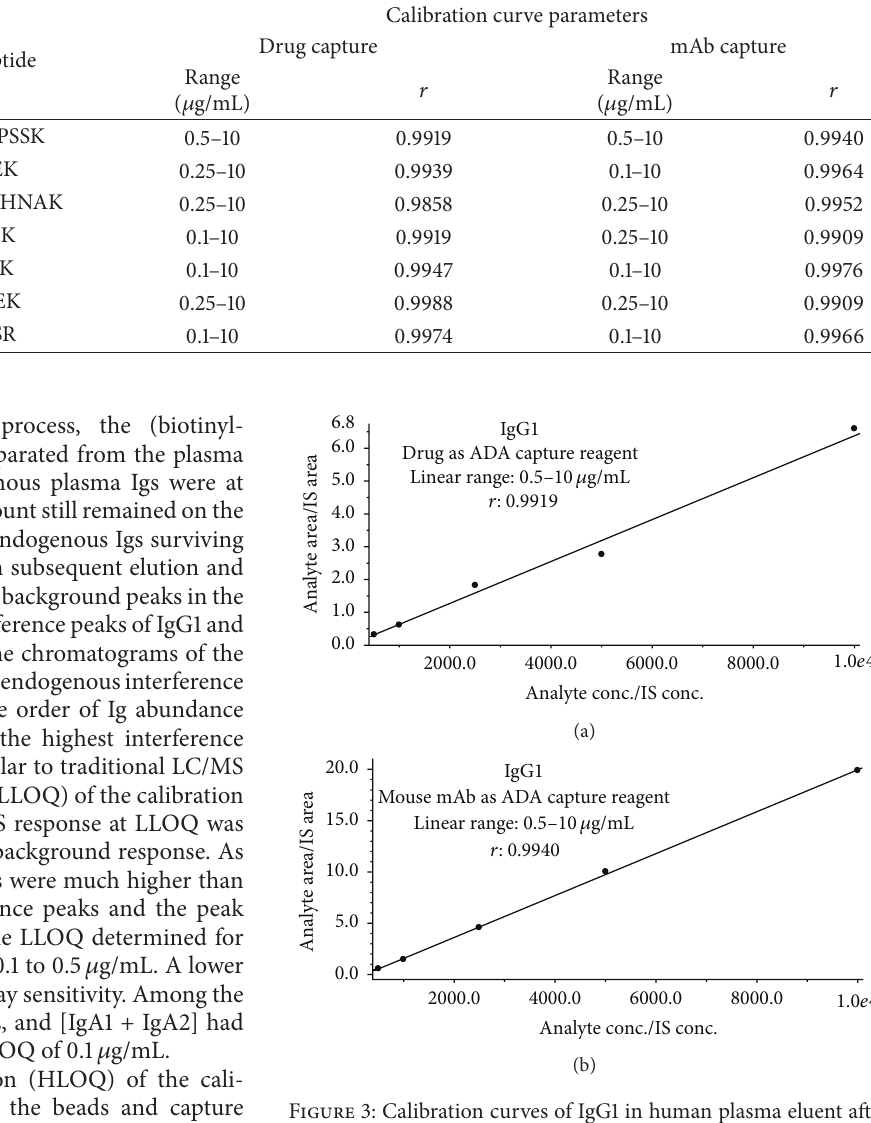
Figure 3: Calibration curves of IgG1 in human plasma eluent after immunocapture when using either drug (a) or mouse mAb as ADA capture reagent